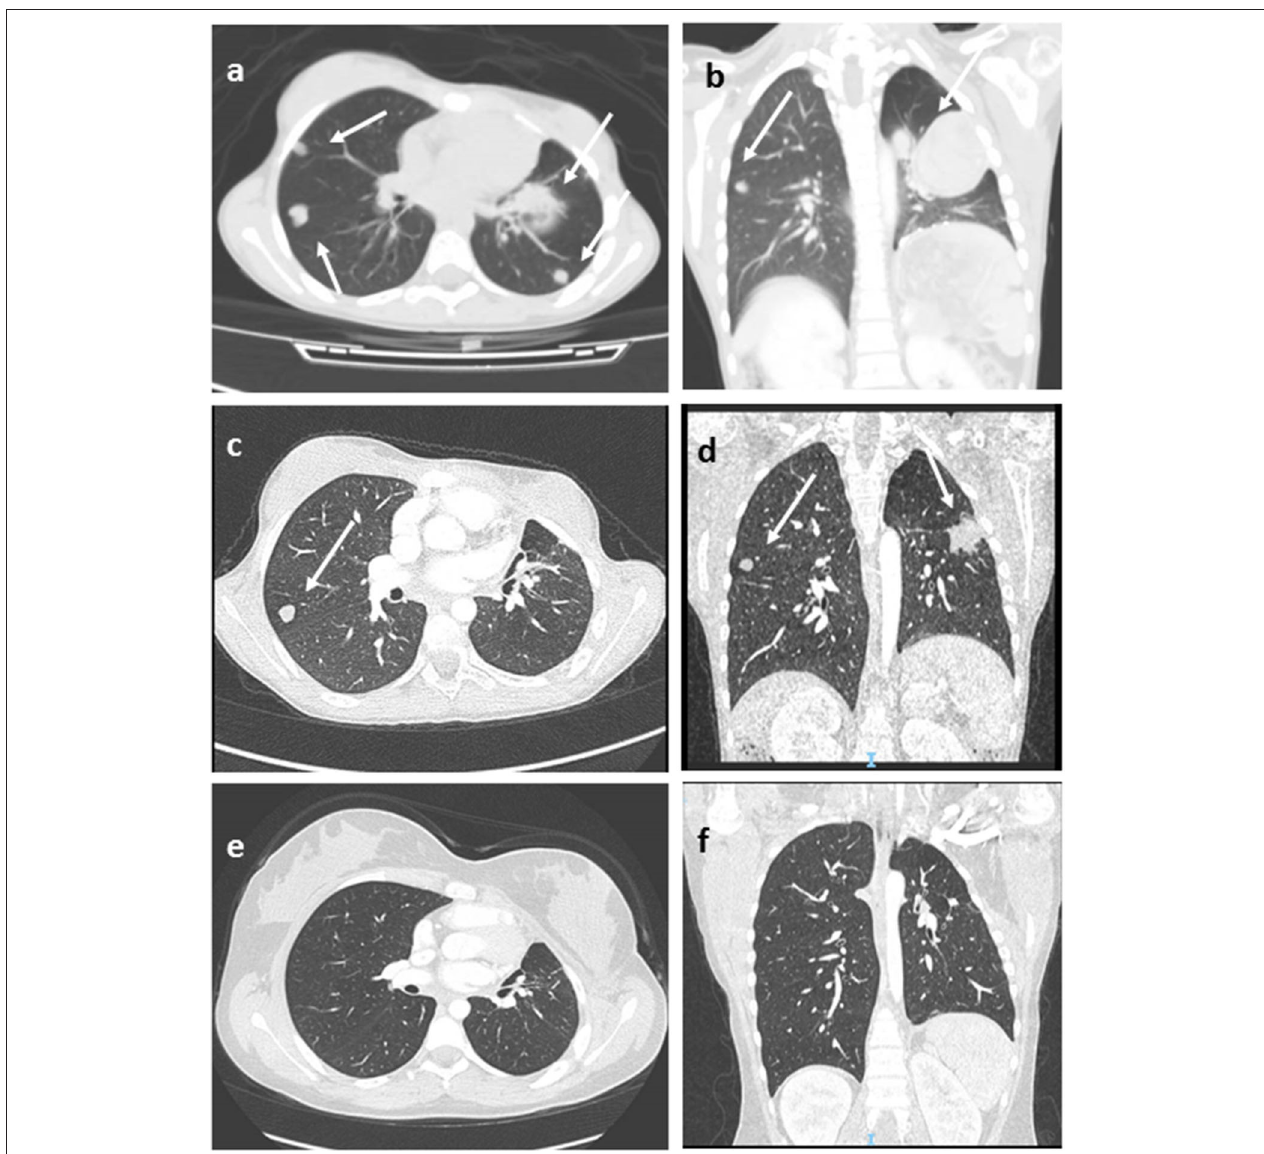
FIGURE 1 | Lung Computed tomography (CT) images (patient #11) showing multiple metastatic lesions (arrows), before (a,b) , after 3 months of pembrolizumab therapy (c,d) , and at last follow-up (e,f) in complete disease remission. Axial (a,c,e) , coronal (b,d,f) .